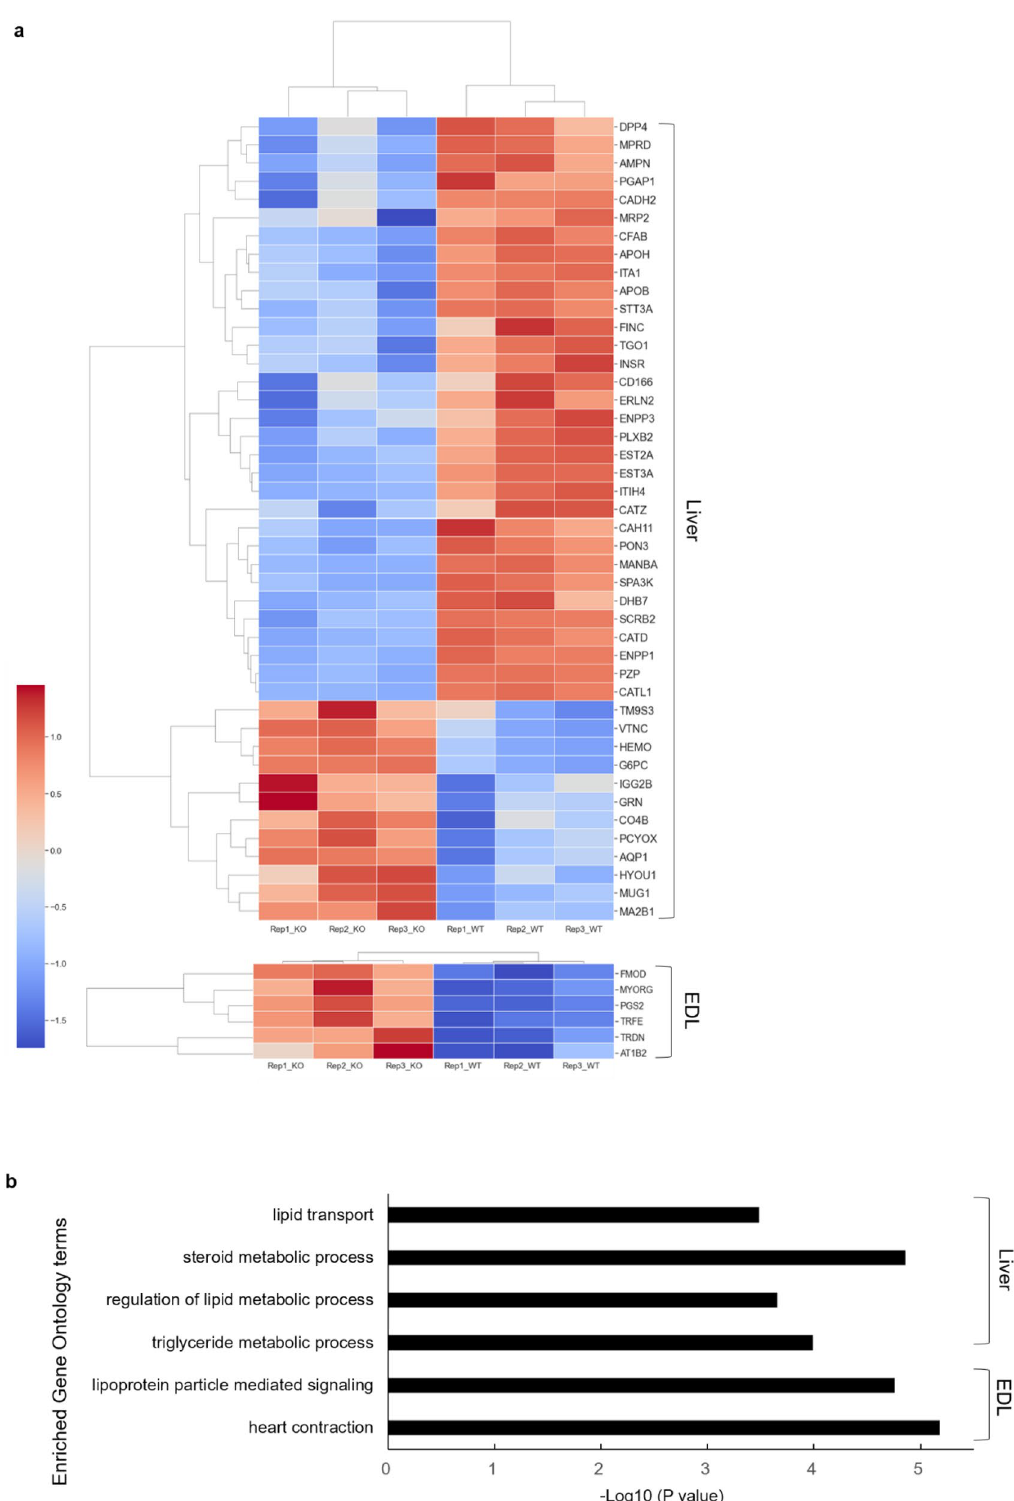
Figure 3. Neu2 Deficiency affects sialylated glycoproteins regulating lipid metabolism and muscle function. ( a ) A heat map of the identified sialylated glycoproteins in the liver and EDL muscle. Glycoprotein intensity analysis and T-test were performed using an in-house program coded by Python 3.8 with the SciPy Stats module, while the heat map was drawn using the Seaborn Clustermap module. ( b ) Biological process enrichment analysis showed identification of sialylated glycoproteins involved in lipid metabolism and muscle functionality. All studies were conducted in control and Neu2 KO littermates 25 weeks of age. WT: n = 1; Neu2 KO: n = 1. Data are obtained in triplicate